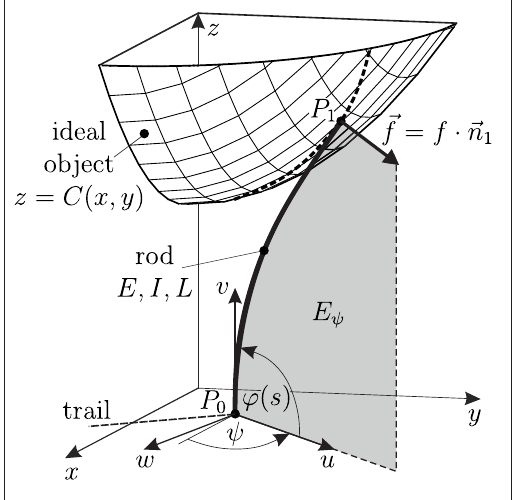
Figure 5. Mechanical model of an artificial vibrissa in ideal contact with an